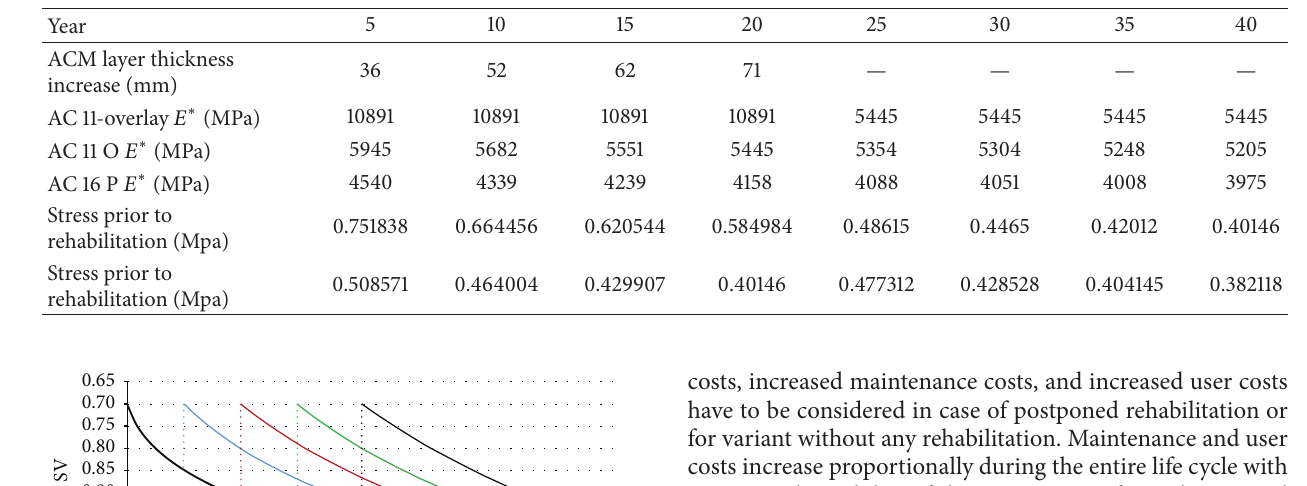
Table 5: Stress calculations before and after rehabilitation.